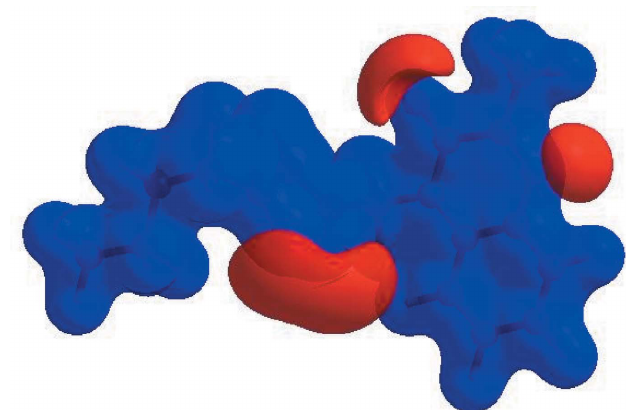
Figure 4 View of the three-dimensional Hirshfeld surface of the title compound plotted over electrostatic potential energy in the range (cid:4) 0.0500 to 0.0500 a.u. using the STO-3 G basis set at the Hartree–Fock level of theory. Hydrogen-bond donors and acceptors are shown as blue and red regions around the atoms corresponding to positive and negative potentials, respectively.